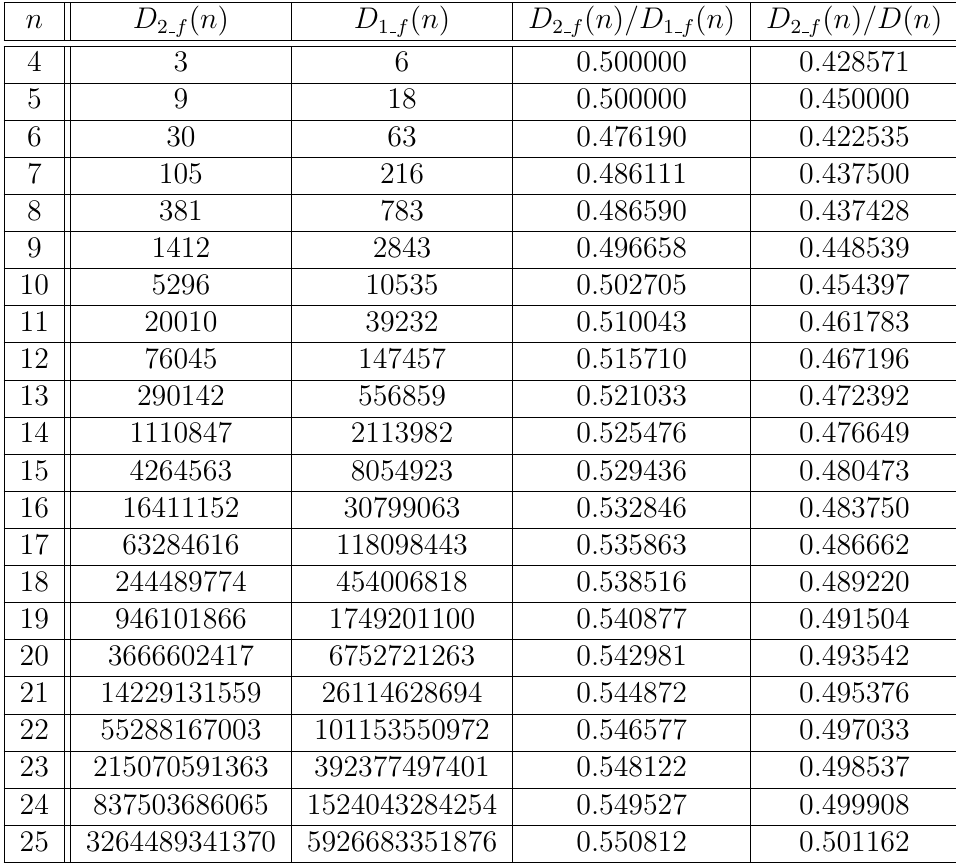
Table 3: Number of forcibly biconnected graphical sequences of length n and their propor- tions in forcibly connected and zero-free graphical sequences of length n